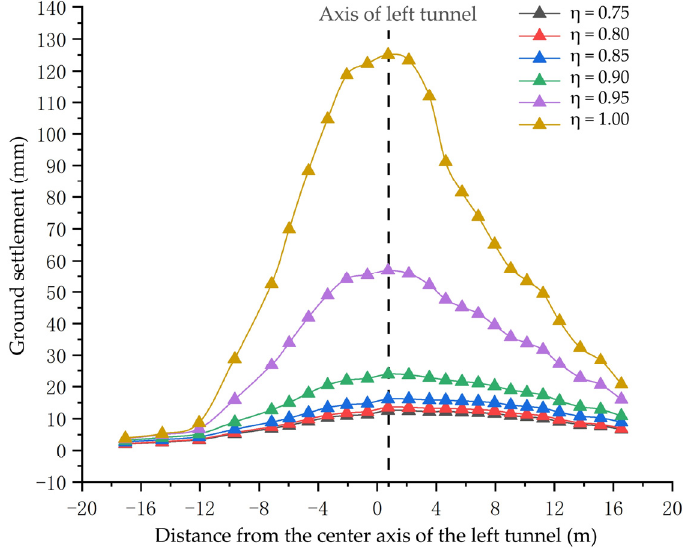
Figure 19. Ground settlement of monitoring points.